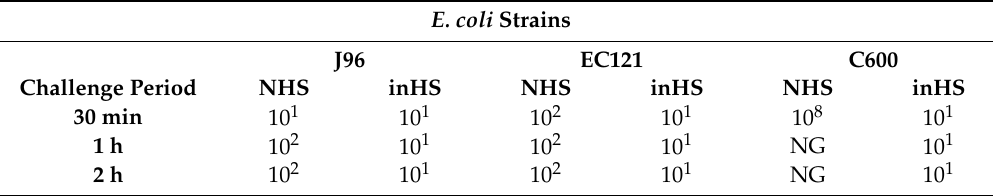
Table 6. Estimated bacterial inoculum resistant to serum activity (CFU / mL).